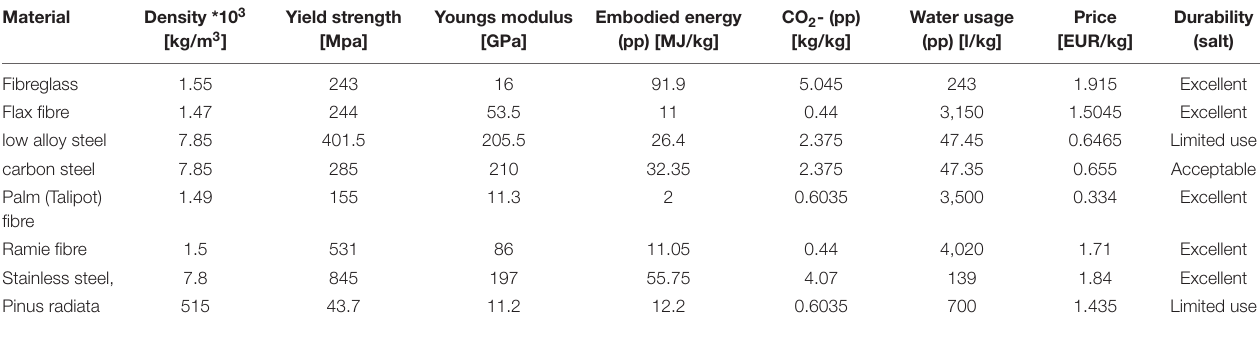
TABLE 3 | Material properties, retrieved from CES